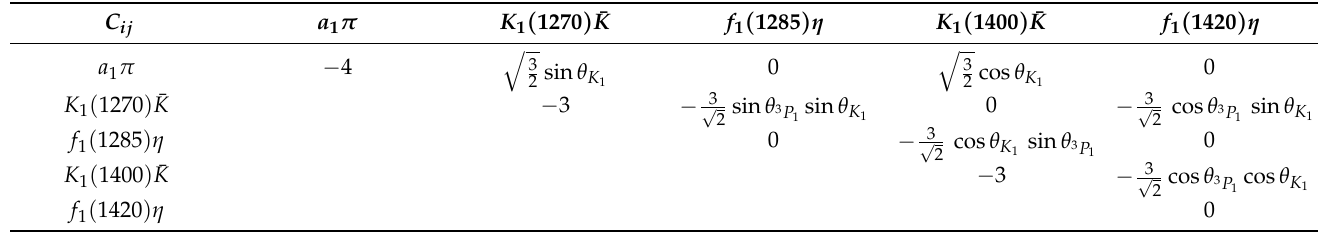
Table 6. C ij coefficients in Equation (16) for axial and pseudoscalar pairs coupled to J PC = 1 − + in S -wave and I = 0.